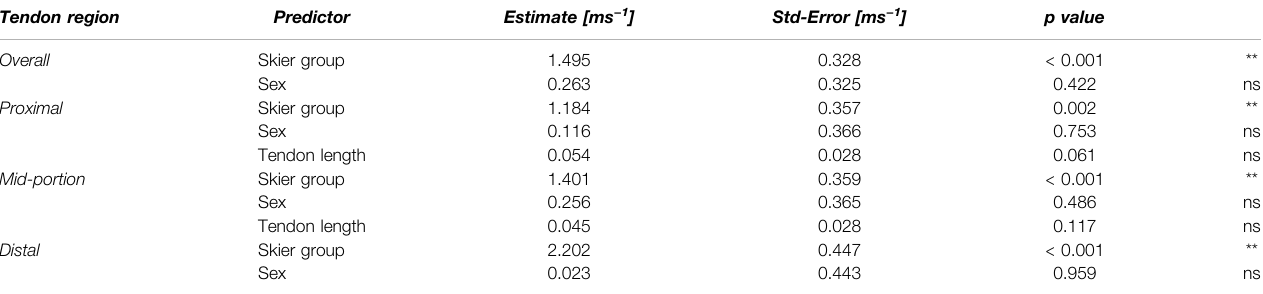
TABLE 2 | Inference models identi fi ed group membership as the only signi fi cant predictor for shear wave velocity of the entire study population in all assessed tendon regions. Tendon region